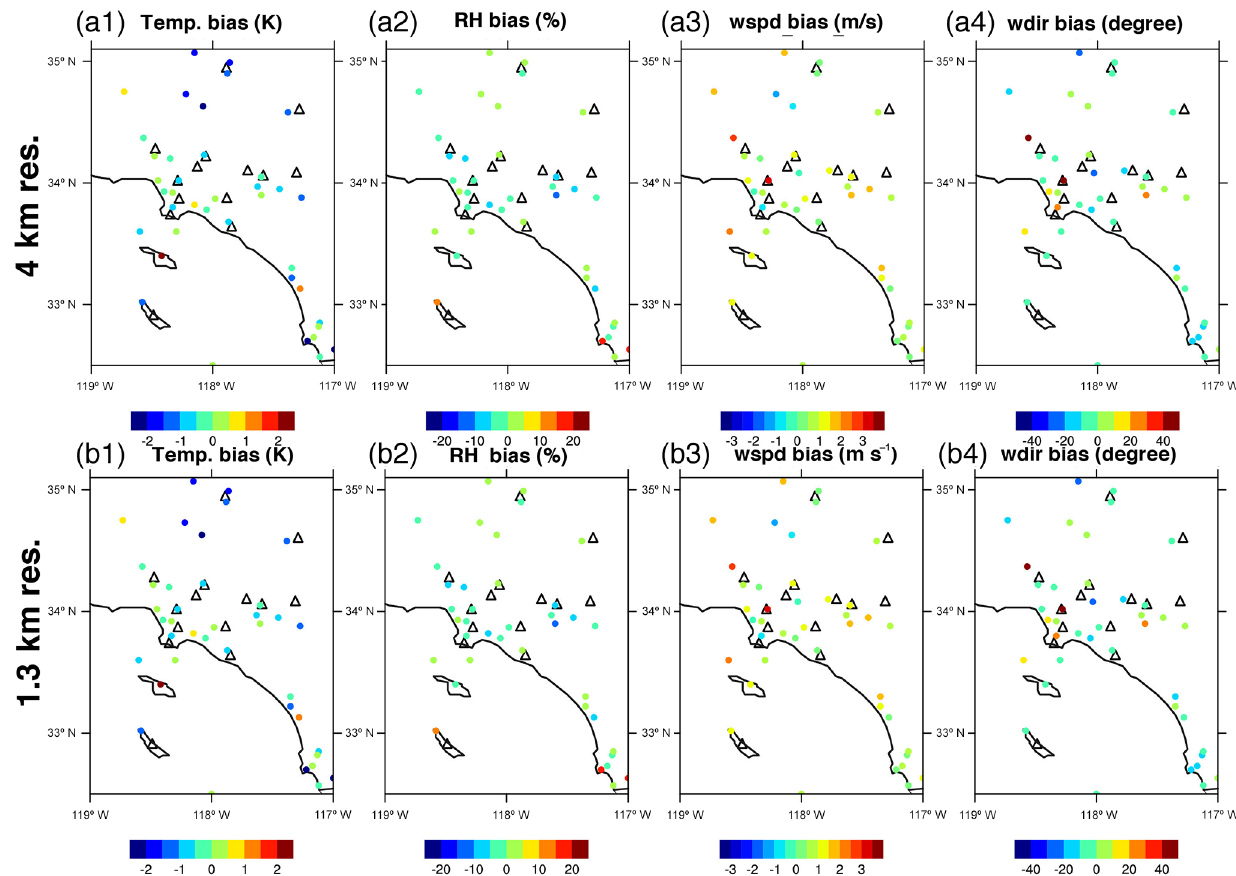
Figure 6. Bias maps of atmospheric state variables from the MYNN_UCM runs versus National Weather Stations (NWS) over the LA megacity (model–NWS): (a1–a4) 4km run; (b1–b4) 1.3km run. Black triangles indicate the locations of the GHG measurement sites. Note daytime 11:00–17:00PST only.